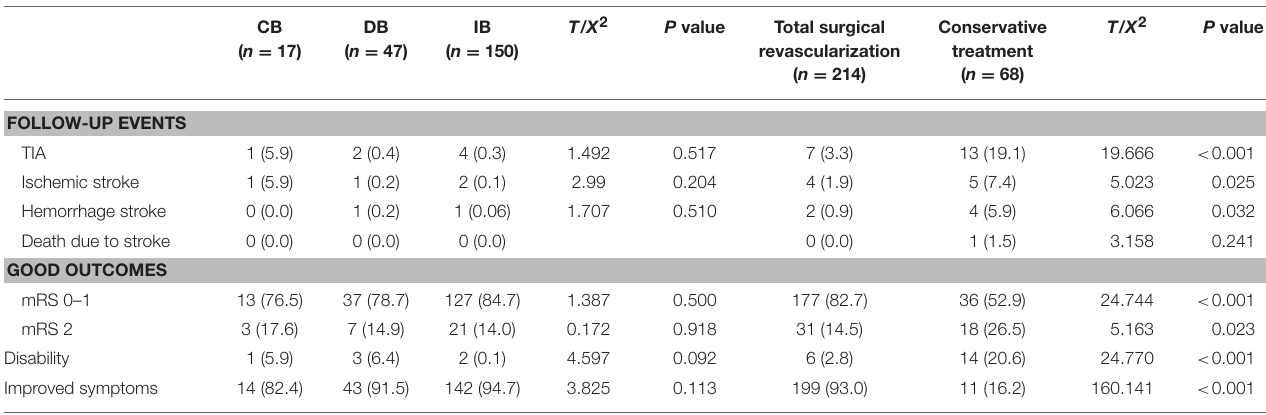
TABLE 3 | Comparison of outcomes between MMD patients with different management methods.